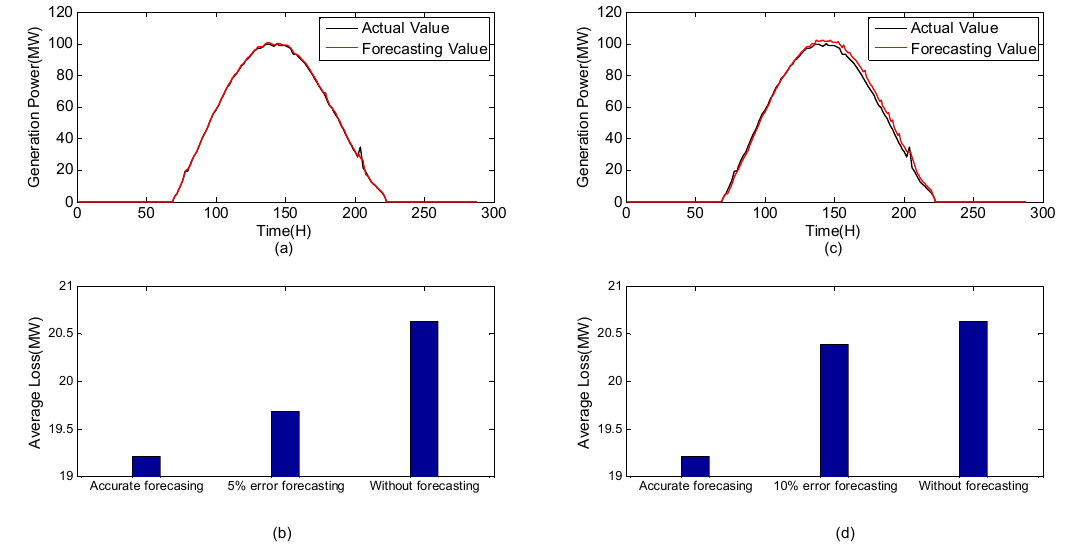
Figure 8. Forecasting results under a 10-min action delay on a sunny day. ( a , c ) show the forecasting results by different iteration time, where the iteration time is 150 s in ( a ) and 125 s in ( c ). ( b , d ) show the average power losses under different settings.